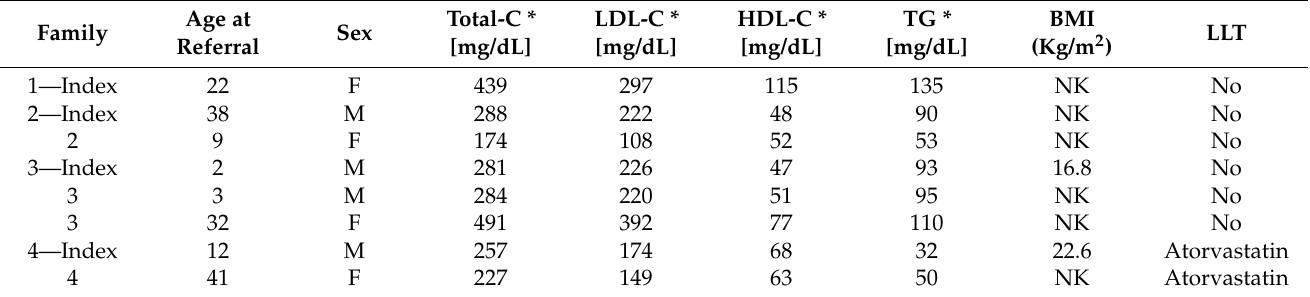
Table 3. Carriers of variant c.1A>C, p.(Met1Leu) found in the Portuguese FH